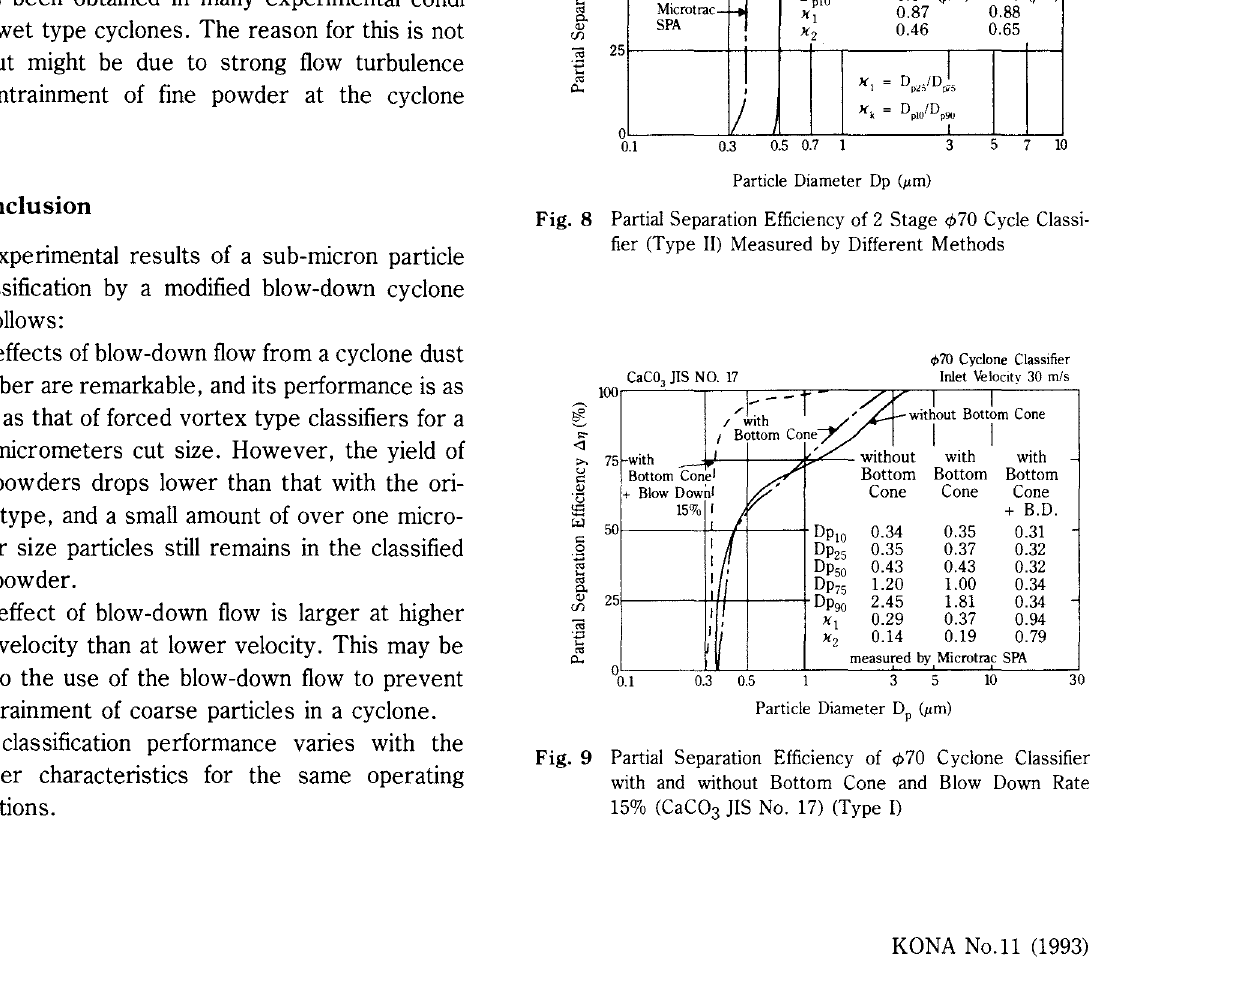
Fig. 7 Partial Separation Efficiency of 2 Stage 1> 70 Cyclone Classifier (Type II)